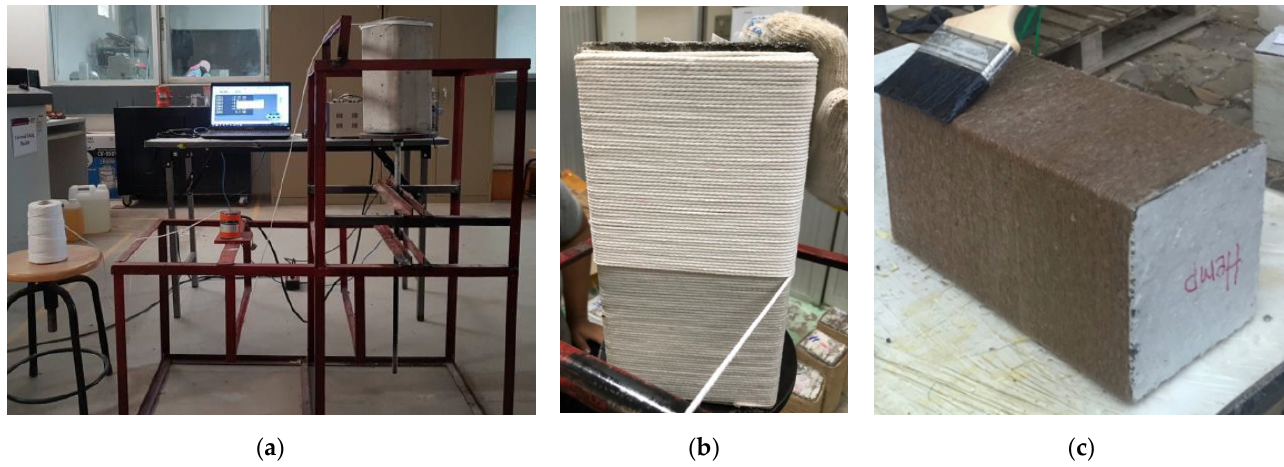
Figure 4. FRRP strengthening process ( a ) mechanical system ( b ) fiber rope wrapping ( c ) application of epoxy resin.